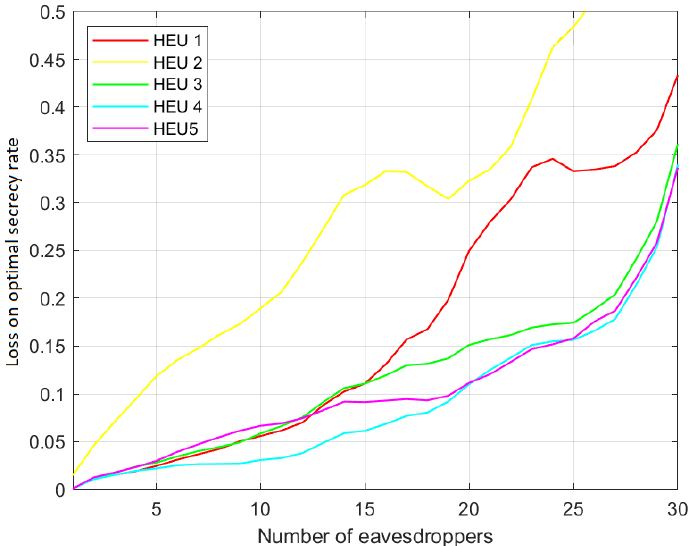
Figure 4. Percentage loss over optimum secrecy rate. Scenario (c) with cooperative eavesdroppers.